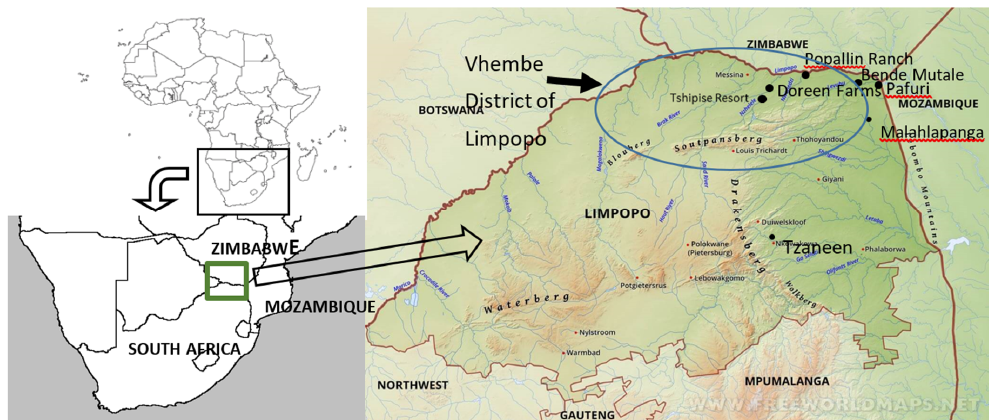
Figure 1. Limpopo River Valley study area.